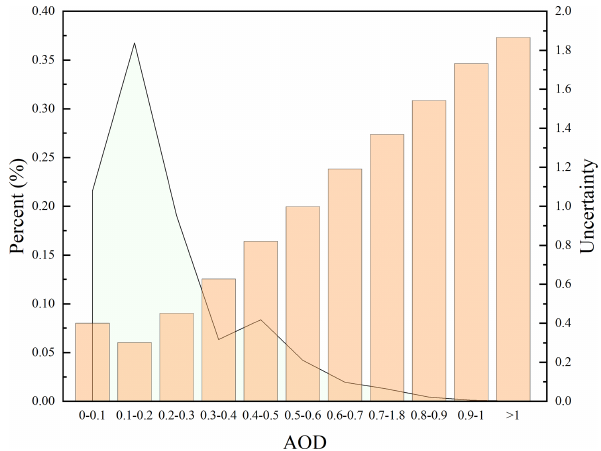
Figure 13. The average uncertainties corresponding to different AOD levels. The light-colored area surrounded by the black line denotes the AOD percentage and the histogram bars reflect the un-